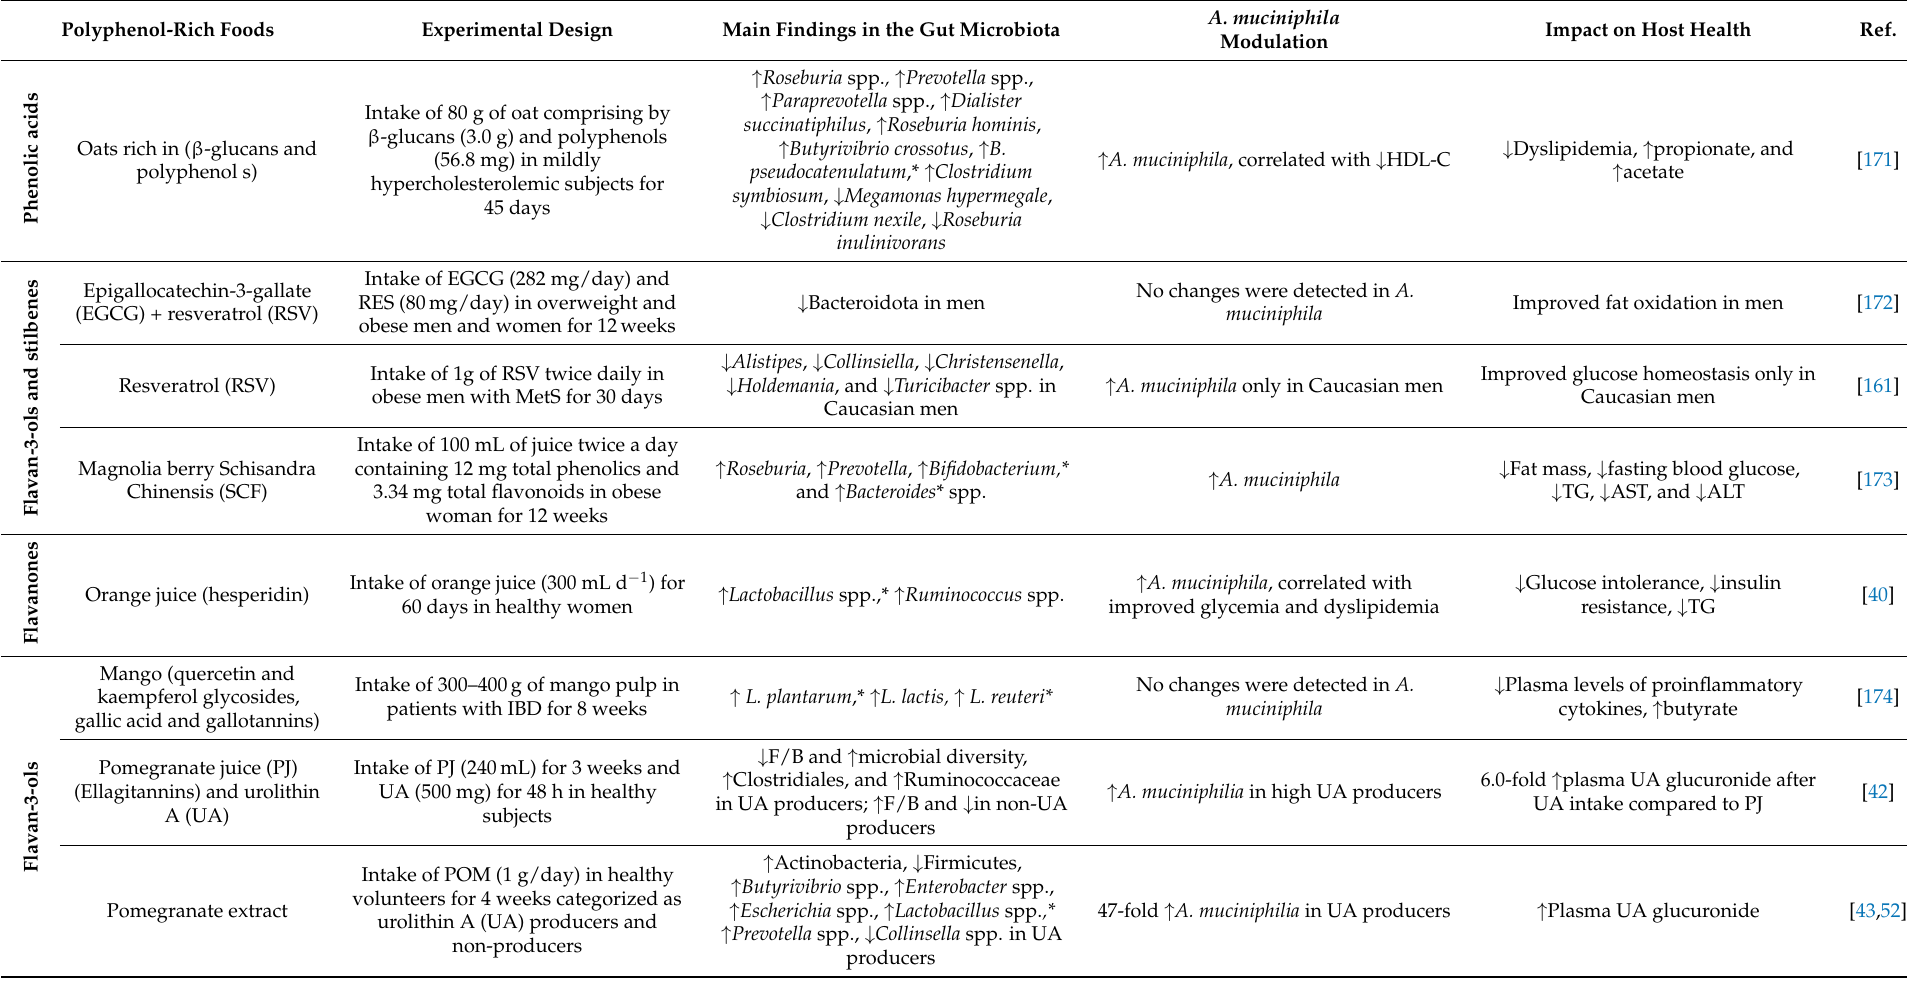
Table 7. Modulation of relative colonic levels of A. muciniphila and other bacteria by polyphenol-rich foods in human intervention trials. Polyphenol-Rich